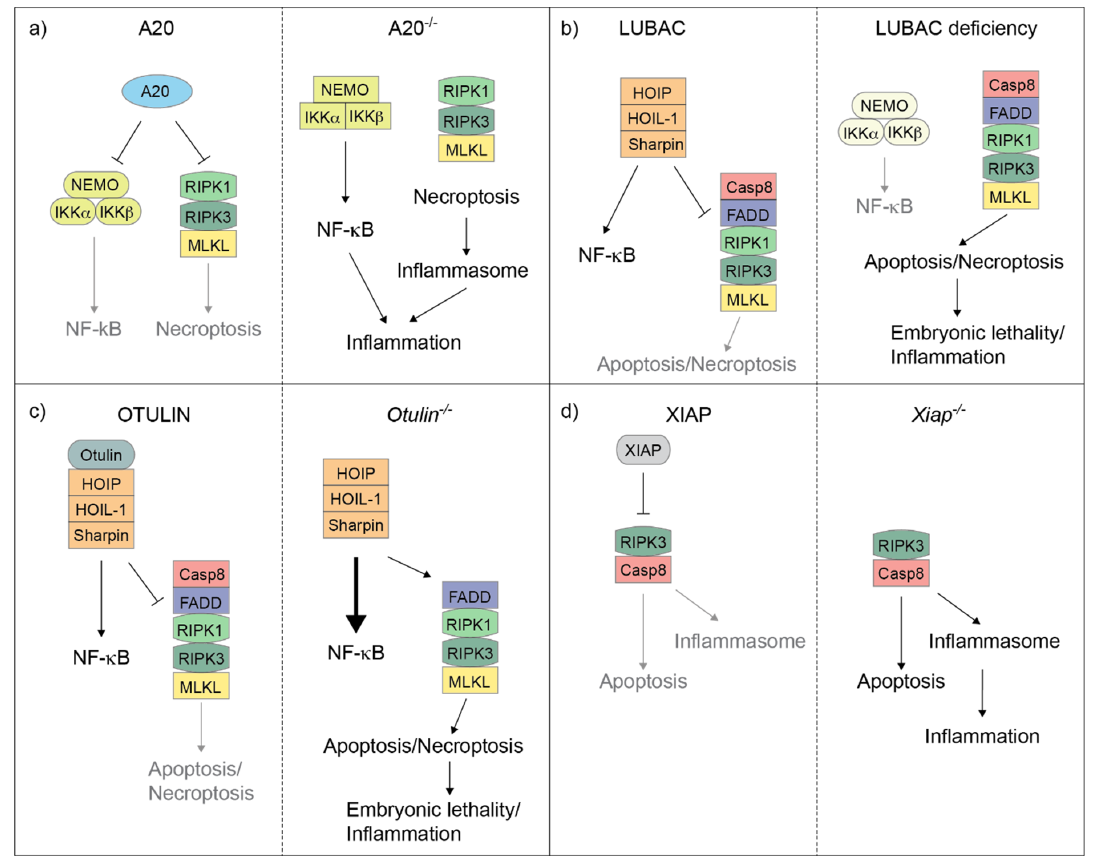
Figure 2. A20, LUBAC, OTULIN and XIAP regulate the balance between cell death and inflammation in mice. Cartoons illustrating how A20 ( a ), LUBAC ( b ), OTULIN ( c ) and XIAP ( d ) control the balance between NF- κ B-mediated gene activation and complex-II-mediated cell death in mouse cells. A20 deletion results in the deregulation of both NF- κ B response and RIPK1/RIPK3/MLKL-induced necroptosis, which, in turn, triggers inflammasome activation ( a ). Individual deletion of the LUBAC components causes an attenuation of NF- κ B response, but an exacerbation of complex-II-mediated cell death, which can result in embryonic lethality or cell death-dependent inflammation in adult mice ( b ). OTULIN deletion leads to hyperactivation of NF- κ B and, at the same time, can unleash complex-II-mediated cell death. This can in turn cause embryonic lethality or cell death-dependent inflammation in adult mice ( c ). XIAP deletion causes both Caspase-8-dependent apoptosis and RIPK3-dependent inflammasome activation, which eventually triggers inflammation ( d